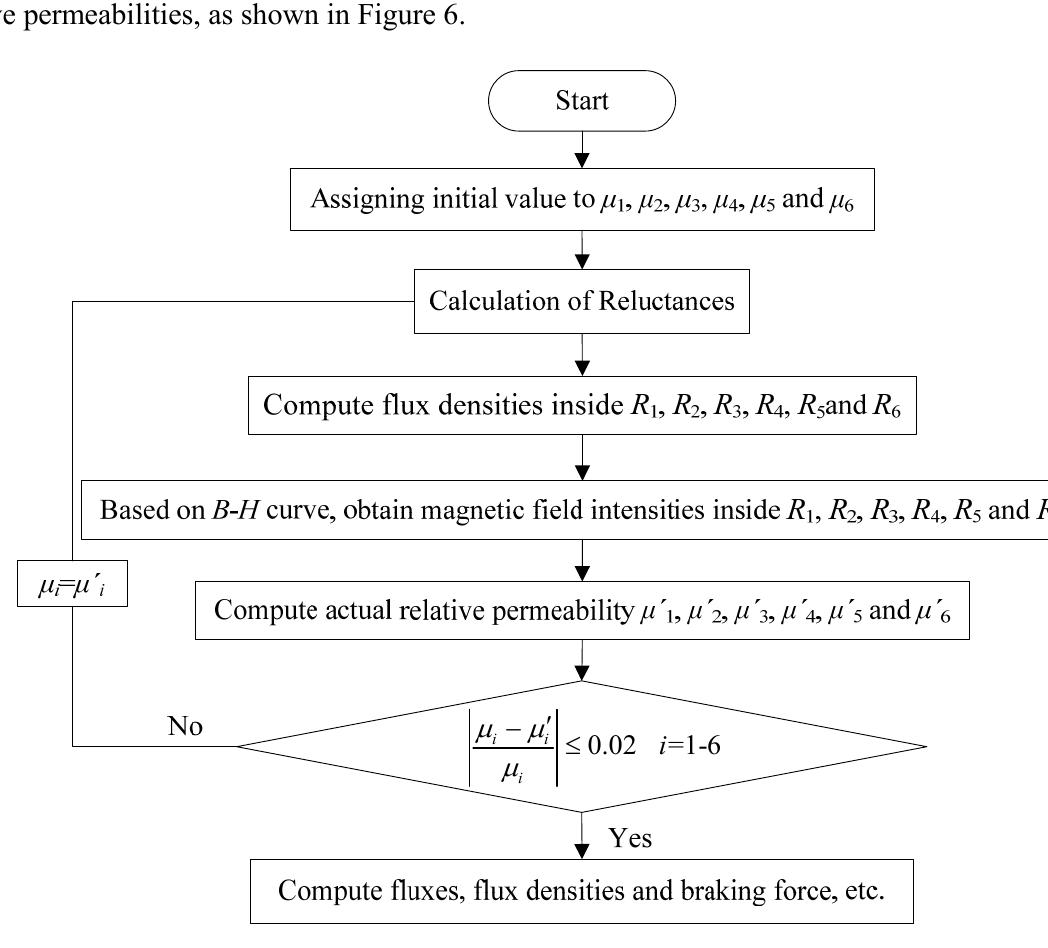
Figure 6. Iterative process of relative